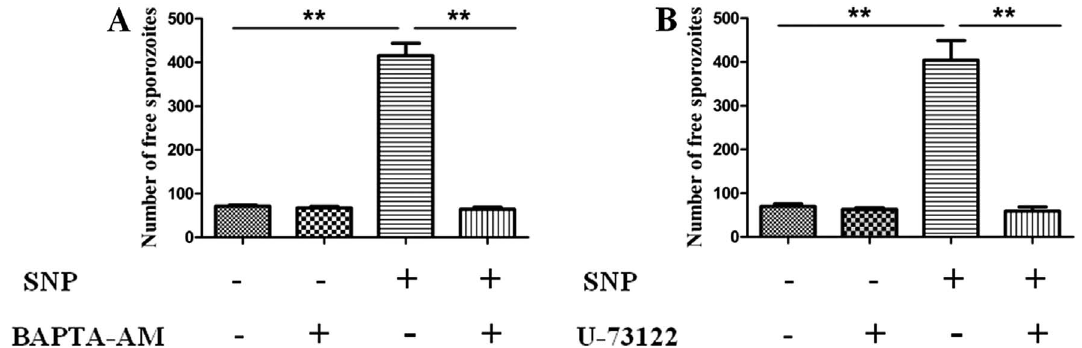
Figure 3. NO-induced egress is required for intra-parasitic Ca 2+ . Sporozoite-infected PCKs were pre-treated with BAPTA-AM (A) or U-73122 (B) for 30 min and then incubated with 40 mM SNP for 30 min. Free parasites were analyzed by fl ow cytometry. Data are means ± SEM of six replicates, representing three independent experiments. ** p <